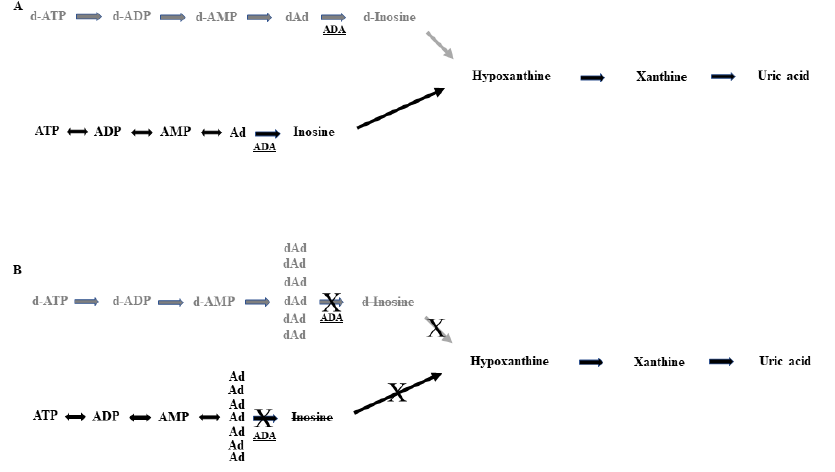
Figure 1. ( A ) Normal integral metabolic purine salvage pathway enables the regulation and availability of purines; ( B ) Disruption of ADA activity prevents the physiological continuation of the purine pathways with increased levels of Ad and dAd. In grey letters, the deoxy-metabolites branches are reported. ADA2 inactivation determines the stop of the dAD to d-Inosine and Ad to Inosine progression, and consequently the downstream final product represented by uric acid, with upstream accumulation of both dAd and Ad metabolites.